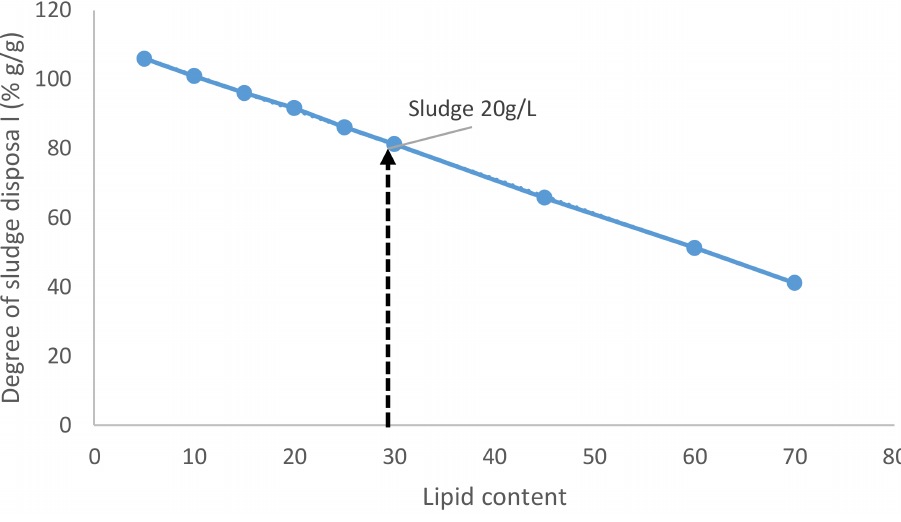
Figure 10. Degree of sludge disposal reduction variation with lipid